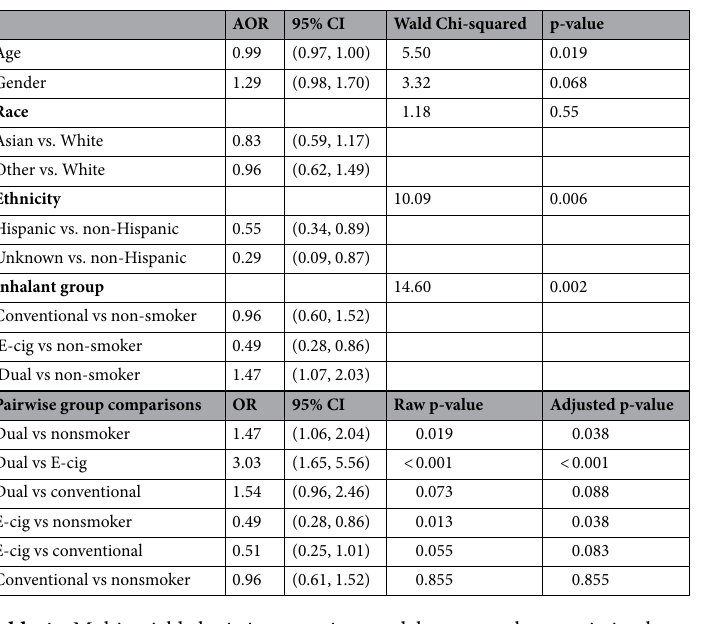
Table 4. Multivariable logistic regression model to assess the association between inhalant groups and presence of cough by LCQ in the past 30 days. This table shows the multivariable logistic regression model with presence of cough in the past 30 days as the outcome, inhalant groups, age, gender, race, and ethnicity as the predictors. The bottom table further shows the pairwise comparisons among inhalant groups with adjusted p-values using the method of Benjamini & Hochberg. Leicester Cough Questionnaire (LCQ) is a tool to assess presence of cough and cough related quality of life; the total score range is from 3 to 21, with higher scores indicating a higher quality of